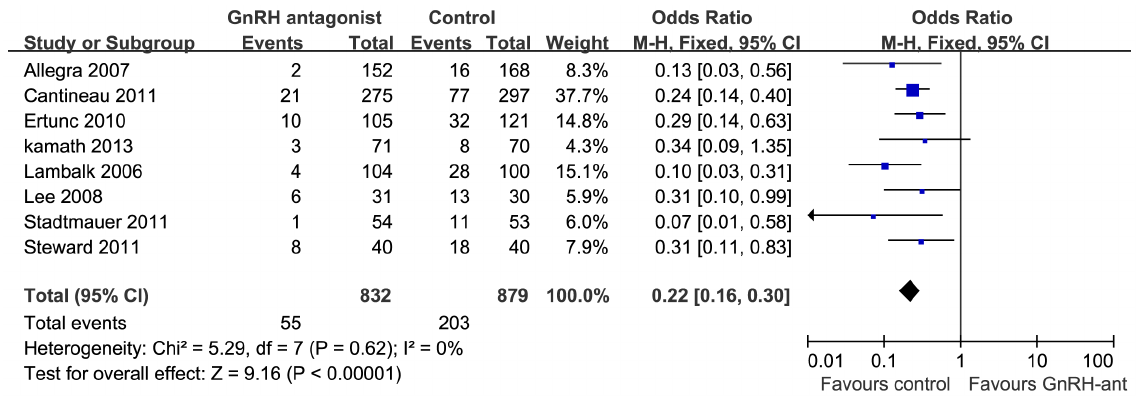
Figure 4. Forest plot of ORs and 95% CI of pooled trials comparing the GnRH antagonist and control for the premature luteinization